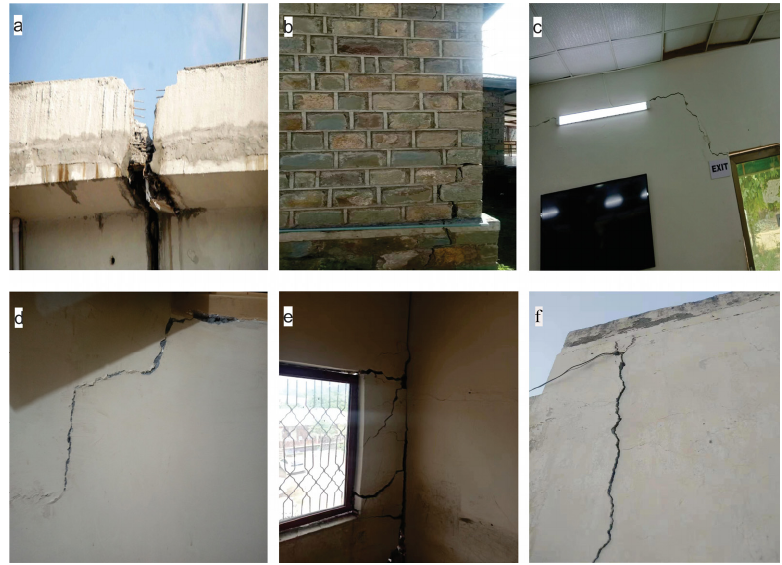
Figure 17. Cracks in the walls of different buildings within the research area. ( a ) Cracks in the pillars of metro track at Committee Chowk, ( b – f ) Cracks in walls of local houses in Raja Bazar, Waris khan, Rehmanabad, and Sadiqabad areas.